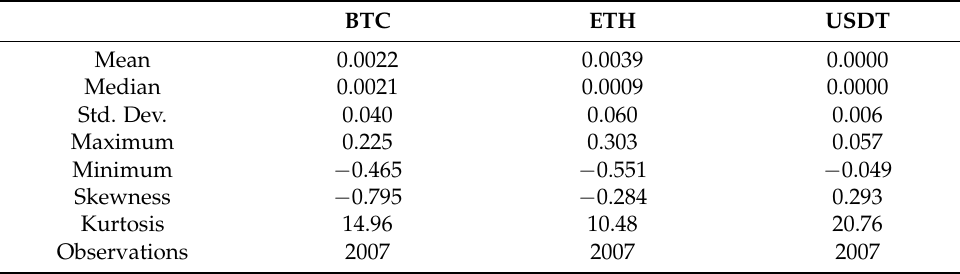
Table 1. Summary statistics for daily returns.